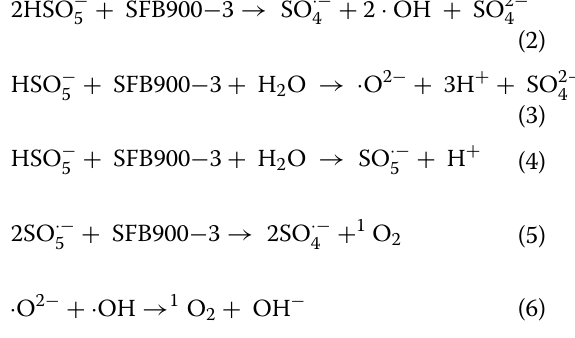
0.2 g L − 1 , [PMS] 0.5 g = =